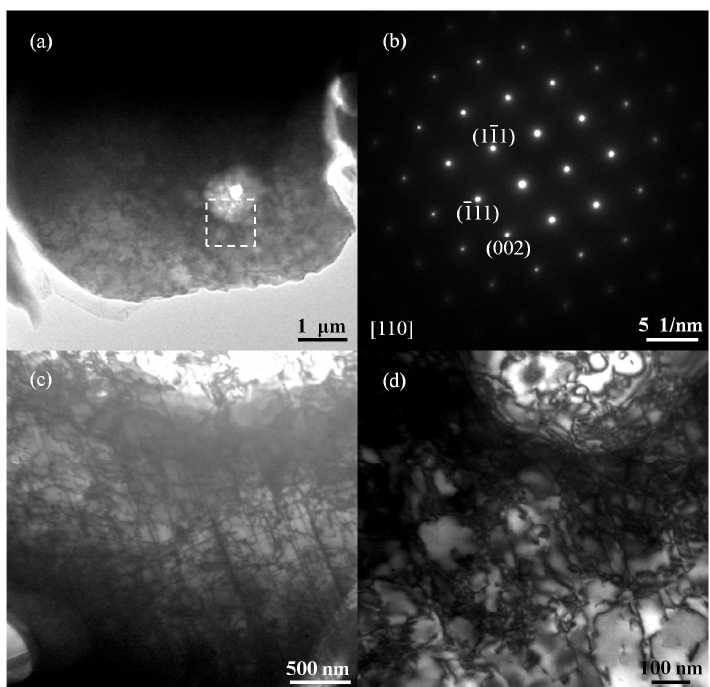
Figure 6. TEM image of the melting zone in the PQ sample: ( a ) bright field image of the melting zone in the PQ sample; ( b ) selected area electron diffraction; ( c ) bright-field image of the selected area; and ( d ) dark-field image of the selected area.